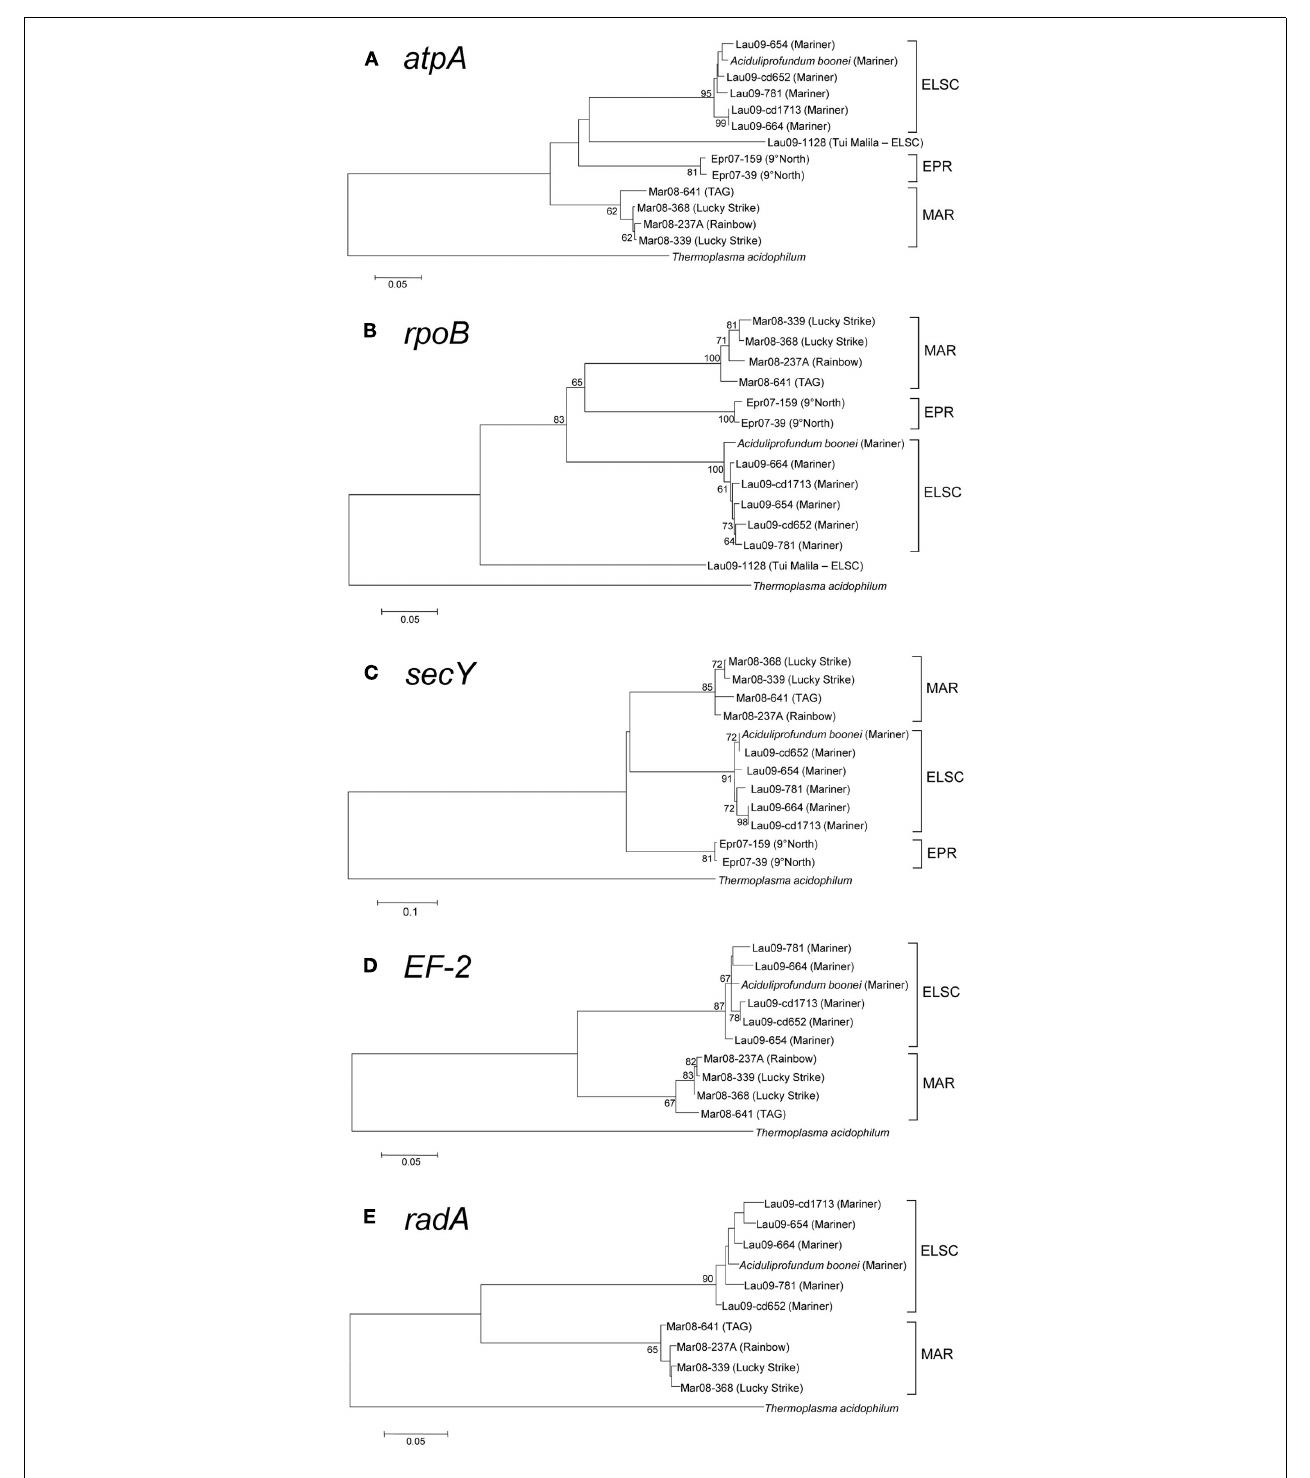
(Tamura, 1992). (D) EF-2 consensus tree generated as in (C) . (E) radA consensus tree generated as in (A) . Bootstrap values greater than 60 are shown at nodes in each tree. Branch lengths are the number of substitutions per site. Gene sequences from Thermoplasma acidophilum were used as outgroups in all trees [Gene ID’s (A) = 1455676, (B) = 1456006, (C) = 1456739, (D) = 1456055, (E) =